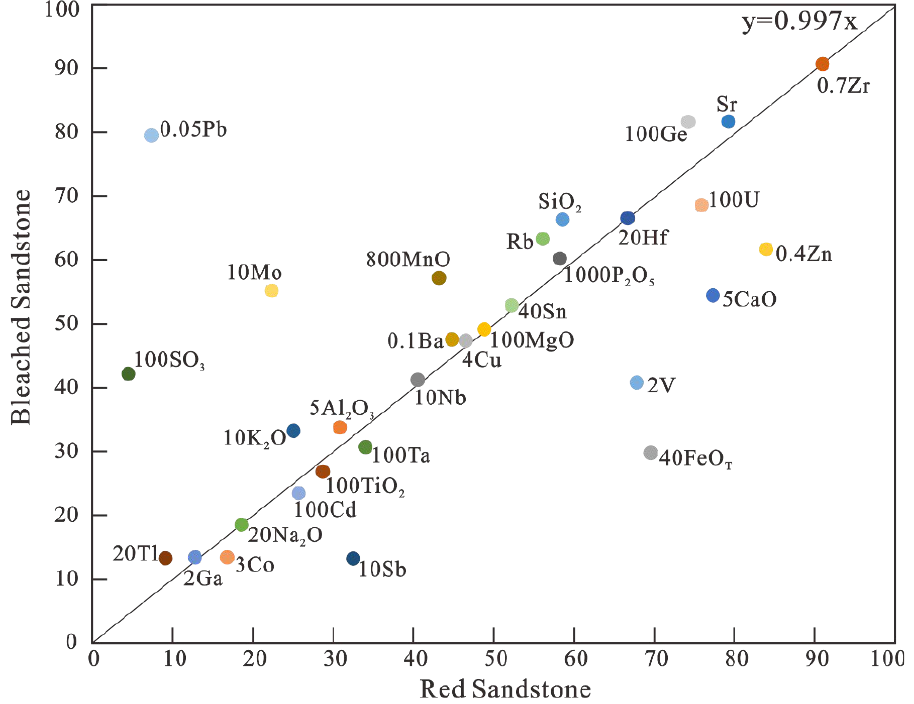
Figure 10. Isocon plots for major (%) and trace elements (ppm) of the red and bleached (slightly mineralized) sandstone at the same sedimentary layer in the fifth member of the Lower Cretaceous Kezilesu Group. Table 1. Major and trace element contents of red and bleached sandstone at the same sedimentary layer in the Uragen Zn–Pb deposit.